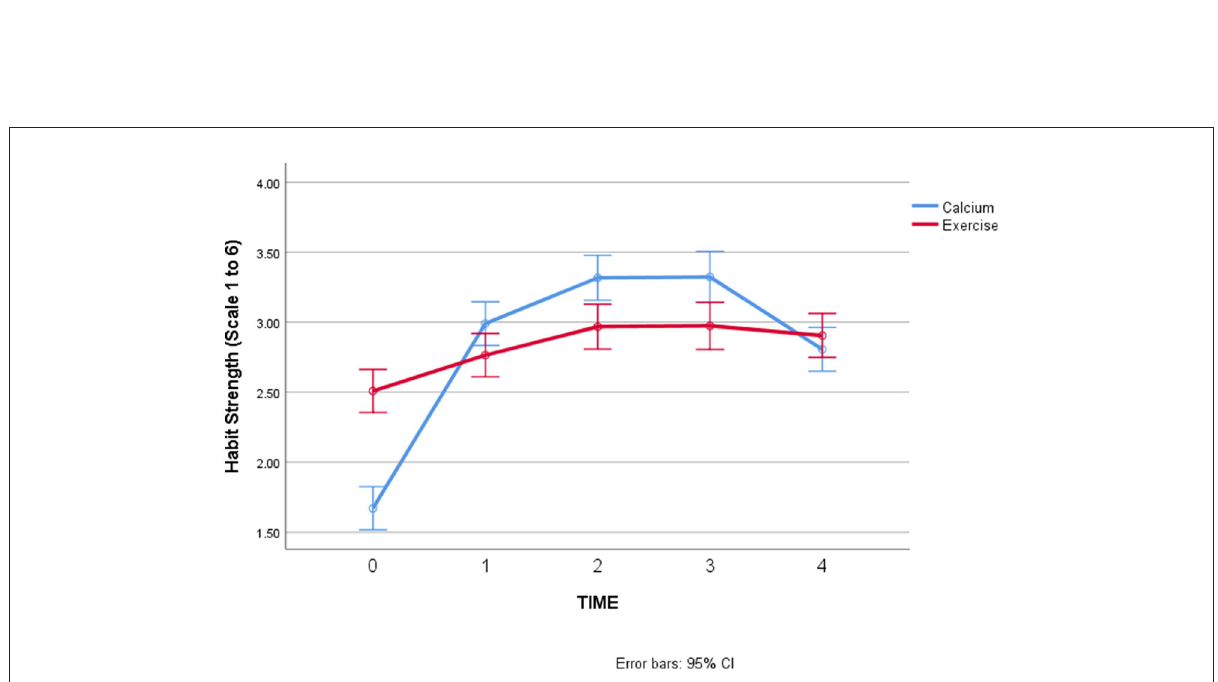
FIGURE1c Changes in habit strength over time, by